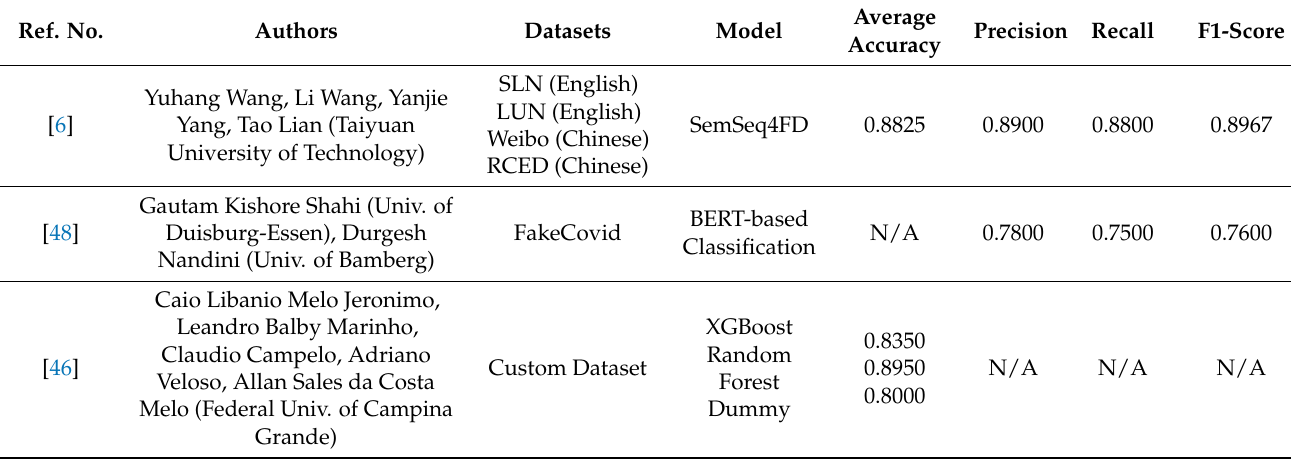
Table 15. Performance Evaluation of Multi-Cross